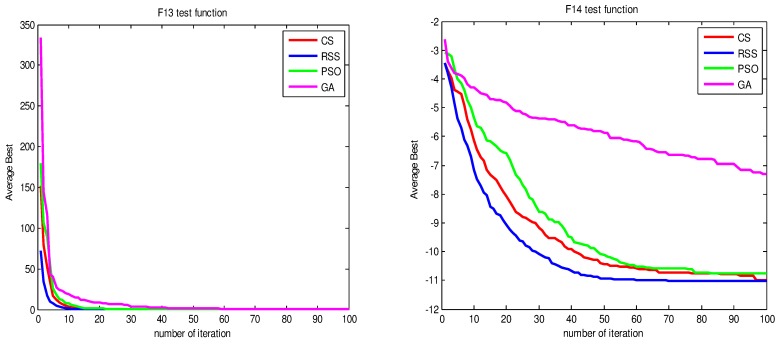
AB convergence of CS, RSS, PSO and GA for minimization of (a) F13 and (b) F14.